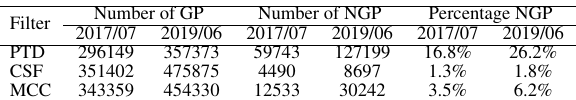
Figure 7. Point cloud maps of the vegetated test area derived from the classified data sets acquired in 2017 (a,b,c,g,h,i) and 2019 (d,e,f,j,k,l). The test area was scanned from the west and north-west direction. The points are coloured following the confusion matrix classification code for each ground filtering technique. The results are shown for the following filtering techniques: PTD (a,g,d,j), CSF (b,h,e,k) and MCC (c,i,f,l). PRE metric (a-f) and REC metric (g-l). See text for full discussion. Table 4. Number of classified Ground Points (GP) and Table 5. Volume change and derived volume bias on the debris Non-Ground Points (NGP) on the debris cone. The filter cone for the different filtering techniques. The filter acronyms acronyms are defined in the text. are defined in the